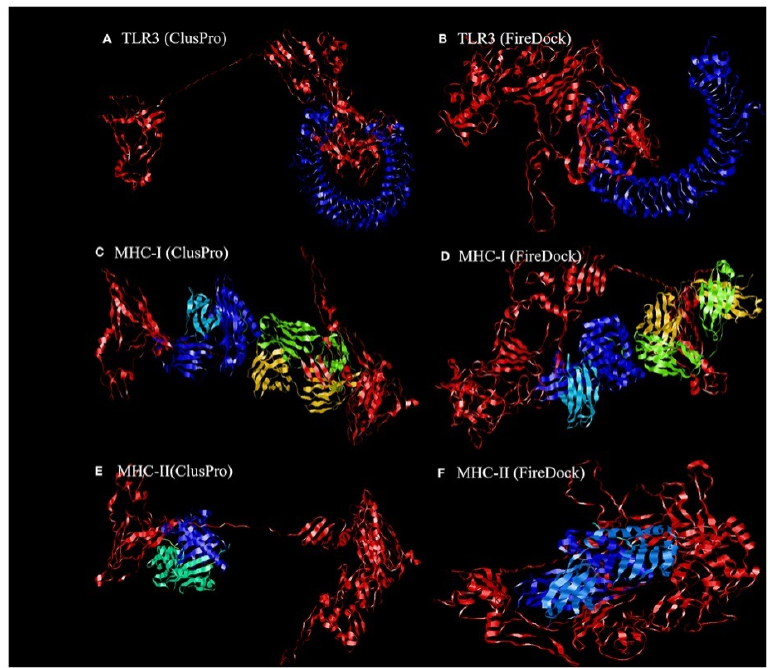
static interaction and the desolvated energy. The server determined a total of twenty-nine model complexes each for TLR3, MHC-I, and MHC-II and the COVID-19 vaccine. The low- est binding energy scores of − 1156.2, − 1346.8, and − 1309 kcal/mol were chosen and are represented in Figure 11. The PatchDock server (https://bioinfo3d.cs.tau.ac.il/PatchDock/ (accessed on 20 October 2021)) was used for further docking evaluation to confirm the bind- Table 1. Static interactions of vaccines with TLR3, MHC-I, and MHC-II. ing affinity between the vaccine construct and the suggested receptors [121]. The top 10 complexes were then refined using the FireDock algorithm [121], which predicts the opti- mal complex with the help of energy functions. The best model complex of TLR3, MHC-I, and MHC-II receptors and the vaccine construct interaction (red color) showed global energy results, attractive van der Waals energy (VdW) results, repulsivevan der Waals (VdW) energy results, and atomic contact energy values (Figure 11, Table 1), verifying the stability of the docked complex.